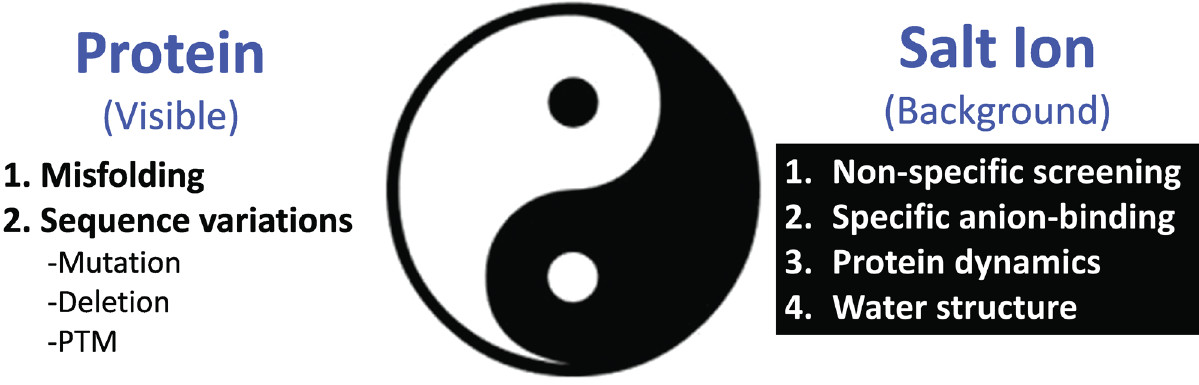
Figure 6. ‘Yang’ and ‘yin’ of protein aggregation. Factors modulating protein aggregation are symbolized by Taji dagram, which are constituted by those from proteins (‘yang’) and salt ions existing in the background (‘yin’). The ‘yang’ part has been exhaustively characterized, which includes misfolding and modifications of proteins such as mutation, deletion and post-translational modifications, etc. By contrast, the ‘yin’ part is only beginning to be recognized, which is involved in the ability of salt ions in imposing non-specific electrostatic screening, specific anion-binding, altering protein dynamics and water structure,